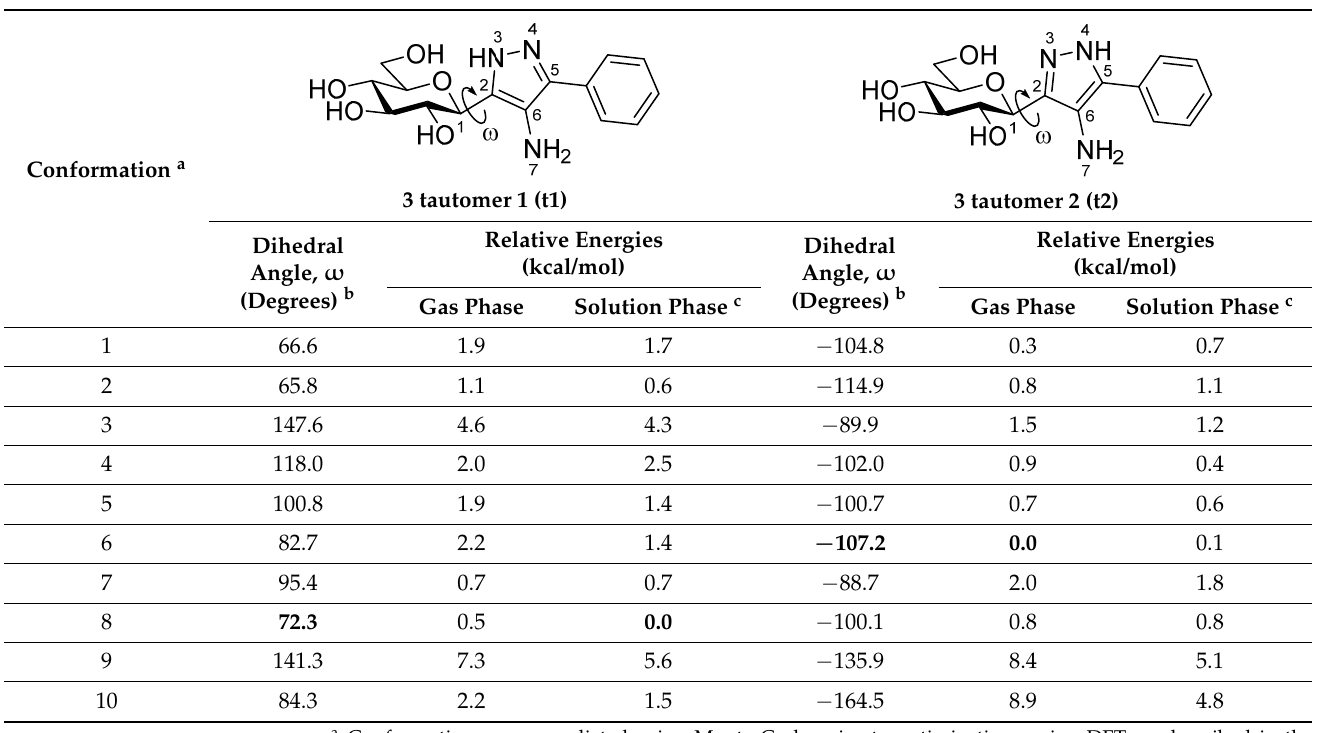
state tautomeric energy differences are predicted as low, as mentioned just above) that is the likely source of the much lower potency of 3 compared to 1 ; the ∆ G (cid:48) bind ( NS ) value is less favourable by 14.3 kcal/mol, while the strain energy and entropy contributions are more similar. Table 2. Relative energies (kcal/mol) of the predicted conformations of compound 3 tautomers t1 and t2 calculated using DFT at the M06-2X/6-31+G* level of theory (gas phase), with water solvation effects additionally accounted for with the SM8 model (solution phase). The most stable calculated state/conformation of the compound is highlighted in bold for each phase.